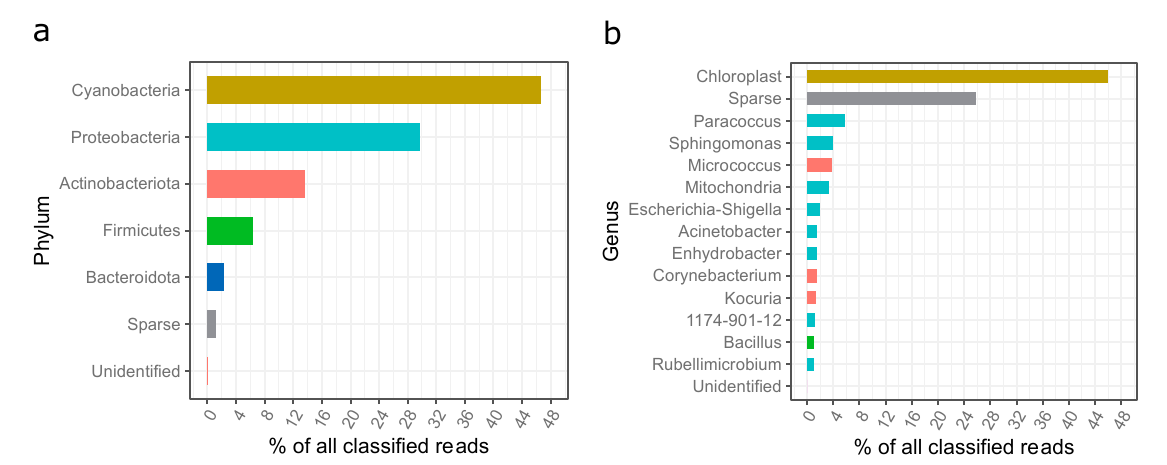
Figure 4. Phylogenetic distribution of bacteria sequences in the settled dust sample; ( a ) assigned to the phyla, ( b ) assigned to the genera; unidentified—unidentified sequences; sparse—reads assigned to low abundant phyla (less than 1% of all classi fi ed reads).